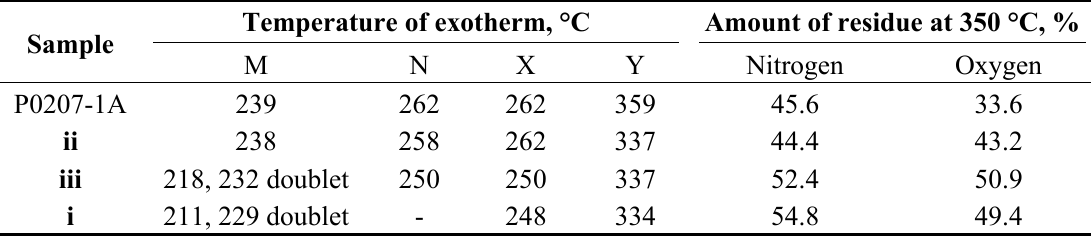
Table 2. Temperatures of the maximum DSC exotherms and residual amount of the sample after the thermogravimetry experiment at 350